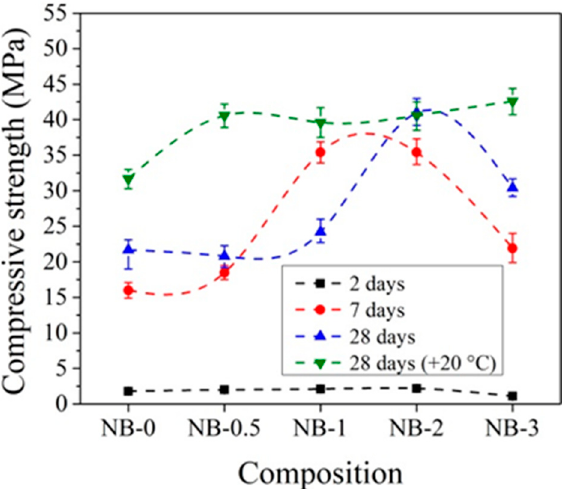
Figure 16. Compressive strength of concrete with CEM IIN samples at − 5 °C initial curing (28 days (+20 °C)—reference samples prepared and cured at +20 °C).